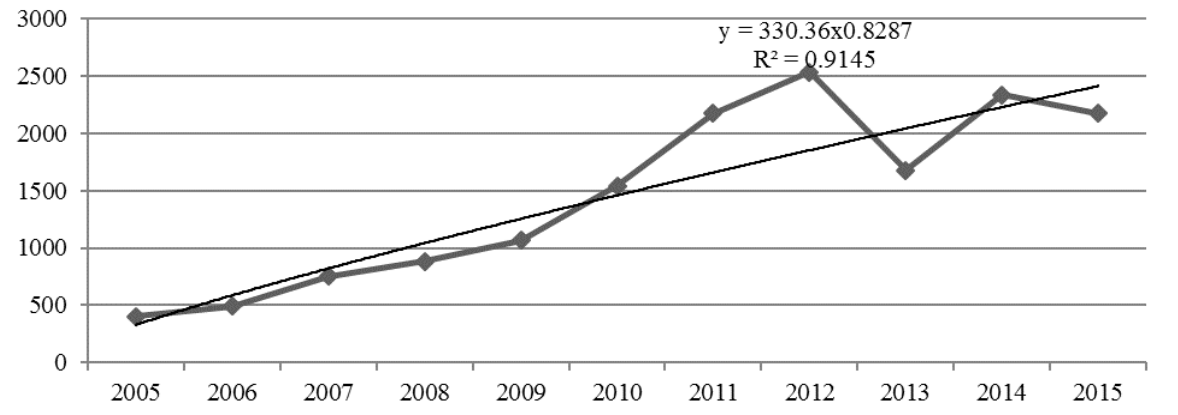
Fig. 1. Definition of the type of growth curve for the indicator of trade volumes on the stock market of Ukraine Table 3. The results of calculations of the correction coefficient and the capacity of the Ukrainian